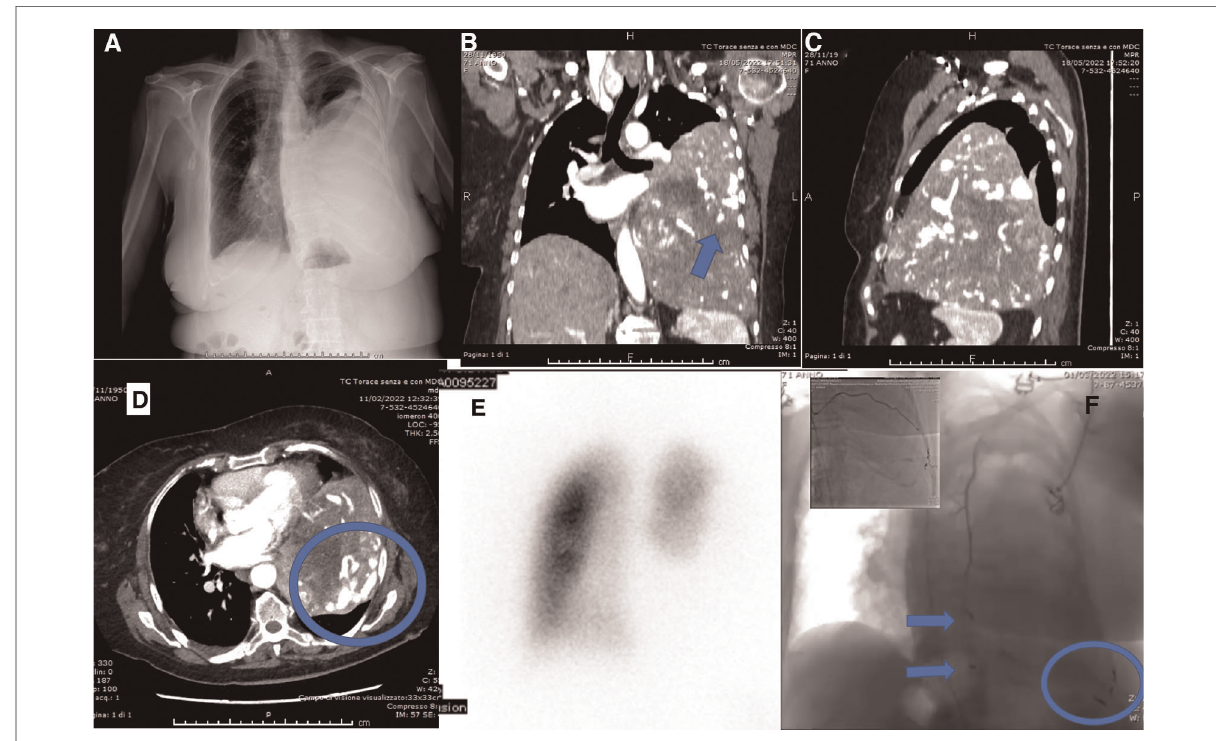
FIGURE 1 ( A ) Preoperative chest x-ray: left side uniformly white with mediastinal shift; ( B ) preoperative chest CT showing the mass with abnormal angiogenesis (arrow), coronal scan; ( C ) preoperative chest CT, sagittal scan; ( D ) preoperative chest CT showing the abnormal tumor angiogenesis (round), axial scan; ( E ) lung perfusion scintigraphy; ( F ) transcatheter arterial embolization (TAE) of X, XI, XII left intercostal arteries (round), left superior phrenic artery (inferior arrow), left internal mammary artery (superior